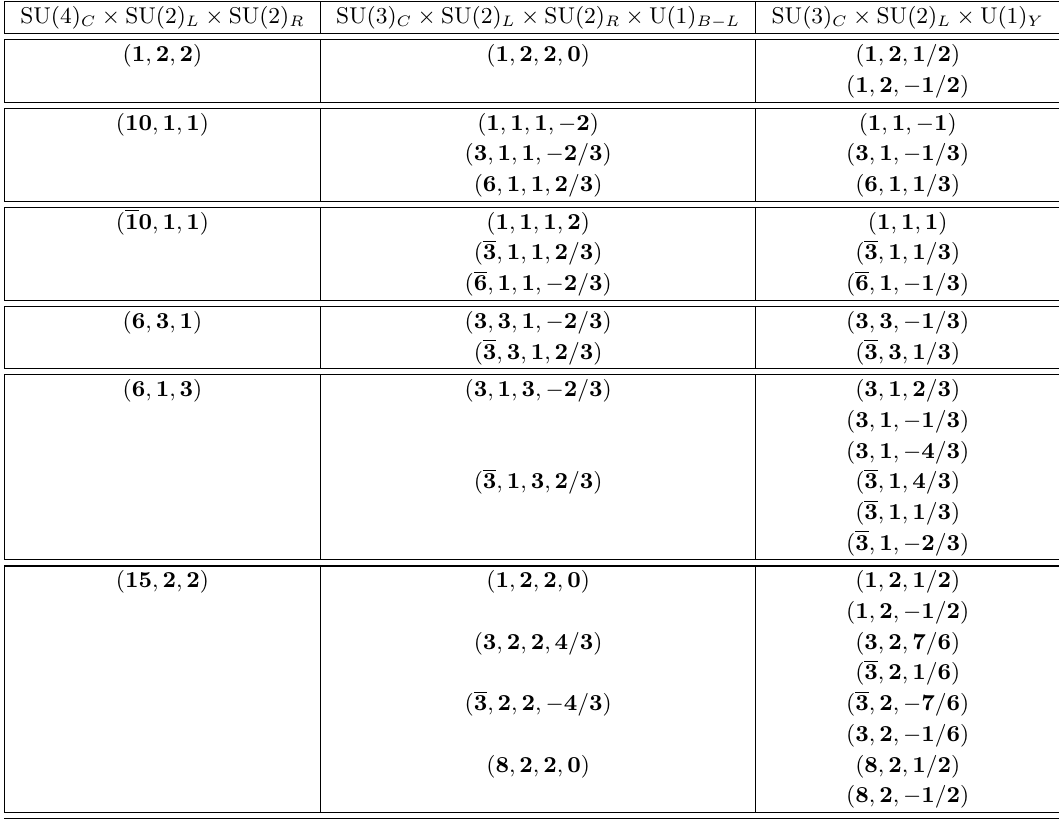
Table 10 . Decomposition of 120 -Higgs, which is a real field. For the simplicity of the analysis, we assume the entire 120 H lives near to the GUT scale and does not contribute to the RGEs. Putting the bi-doublet at the intermediate scale, however, can be straightforwardly